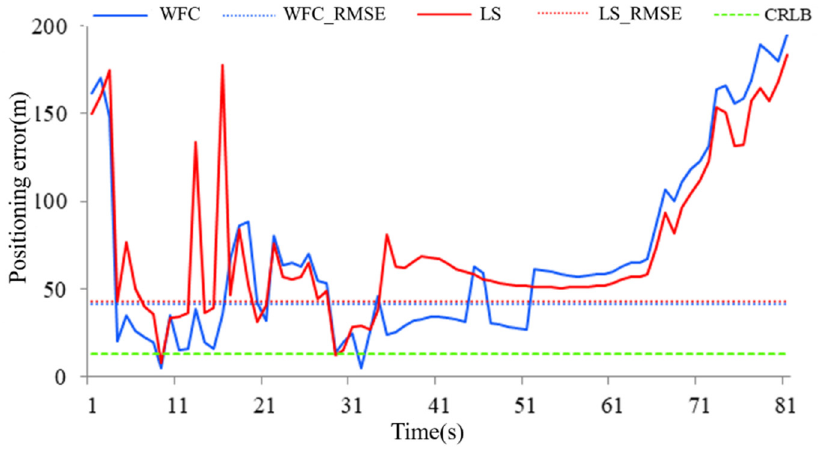
Figure 11. WFC fusion method analysis of the positioning accuracy.